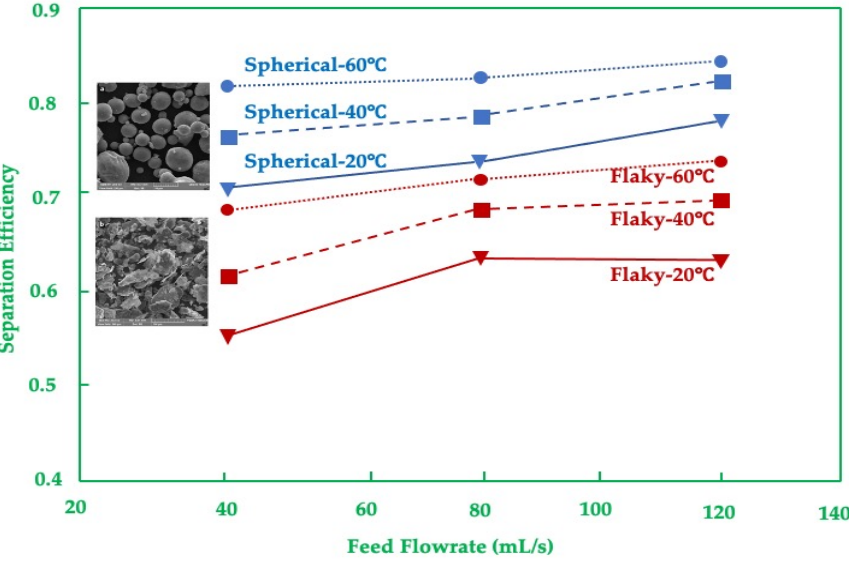
Figure 26. Comparison of spherical and flaky particles according to their separation efficiency and feed flow rate (modified from [342]).